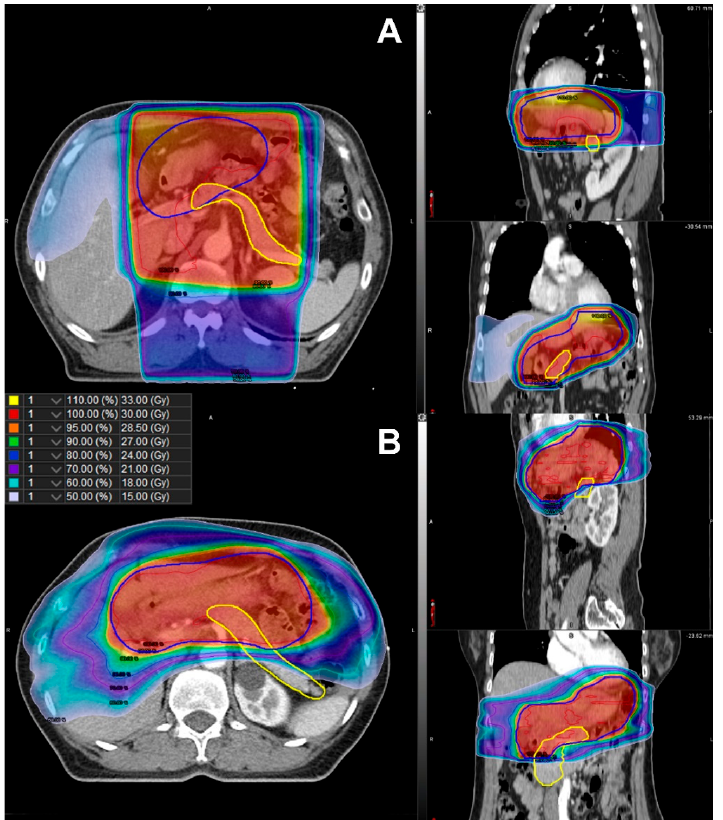
Figure 3. Comparison of isodose distribution of the planning target volume (blue line) and the pancreas (yellow line) in ( A ) three-dimensional conformal radiotherapy with D mean ≥ 21.0 Gy and ( B ) intensity-modulated radiotherapy with D mean < 21.0 Gy. D mean , mean dose in gray irradiated to the whole